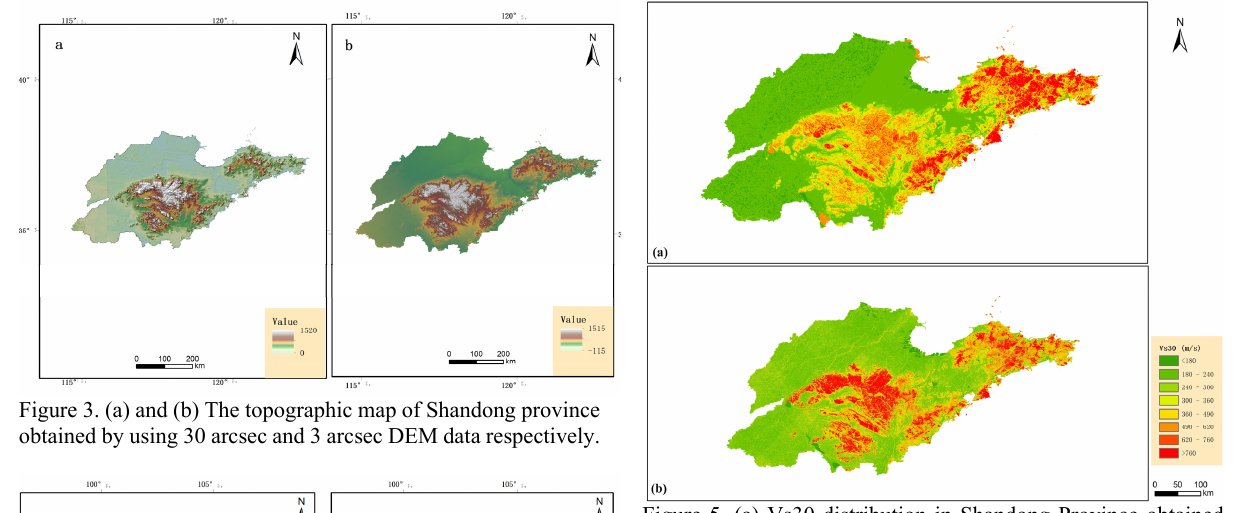
Figure 5. (a) Vs30 distribution in Shandong Province obtained from 30 arcsec DEM data. (b) Vs30 distribution in Shandong Province obtained from 3 arcsec DEM data.